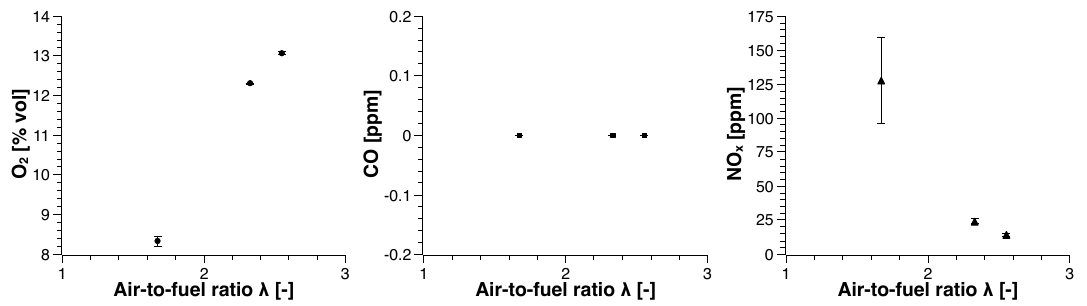
Figure 13. Concentrations of O 2 (% vol), CO (ppm), and NO x (ppm) as a function of air-to-fuel ratio λ . Air inlet temperature 700 ◦